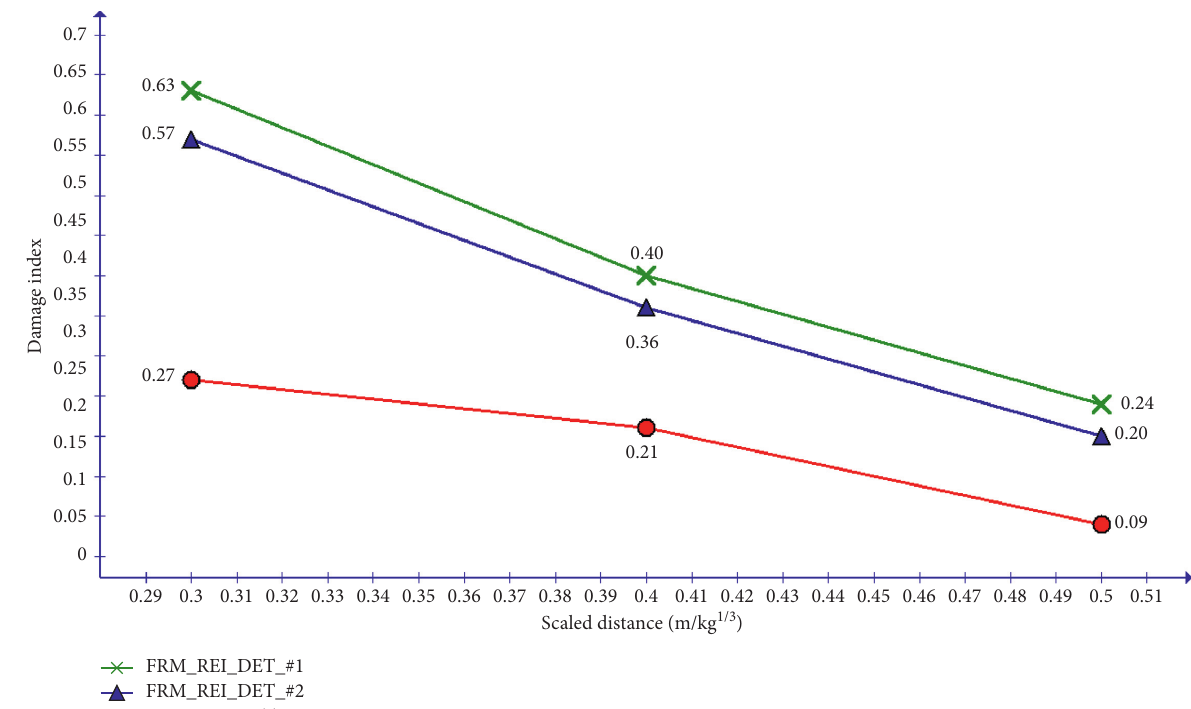
Figure 26: 2 nd story column damage index values for different reinforcement detailing provisions under various scaled